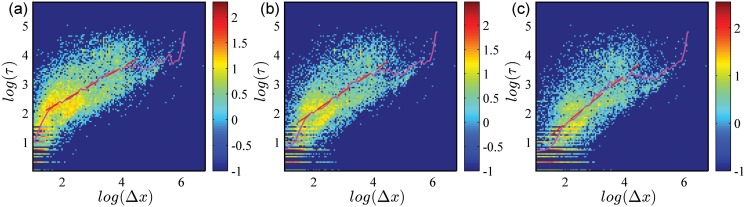
The heat map of the staying time τ in the region with radius ρd vs. the displacement Δx that the user travels into the region.Here ρ = 0.500 (a), ρ = 0.250 (b) and ρ = 0.125 (c). The color is proportional to the logarithm of the heat (count) on each data point. The magenta curves provide the log-binning result of the relationship τ vs. Δx, and the red dashed lines are the fitting power functions of the log-binning curves, where fitting slopes γ = 0.58 ± 0.01 for (a), γ = 0.69 ± 0.02 for (b) and γ = 0.82 ± 0.03 for (c).